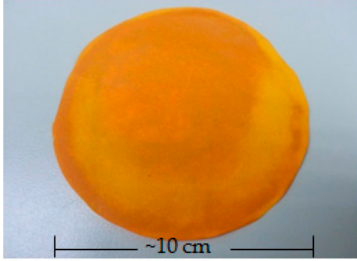
Figure 2. Photograph of bacterially derived cellulose-composite membrane (CM200:8).